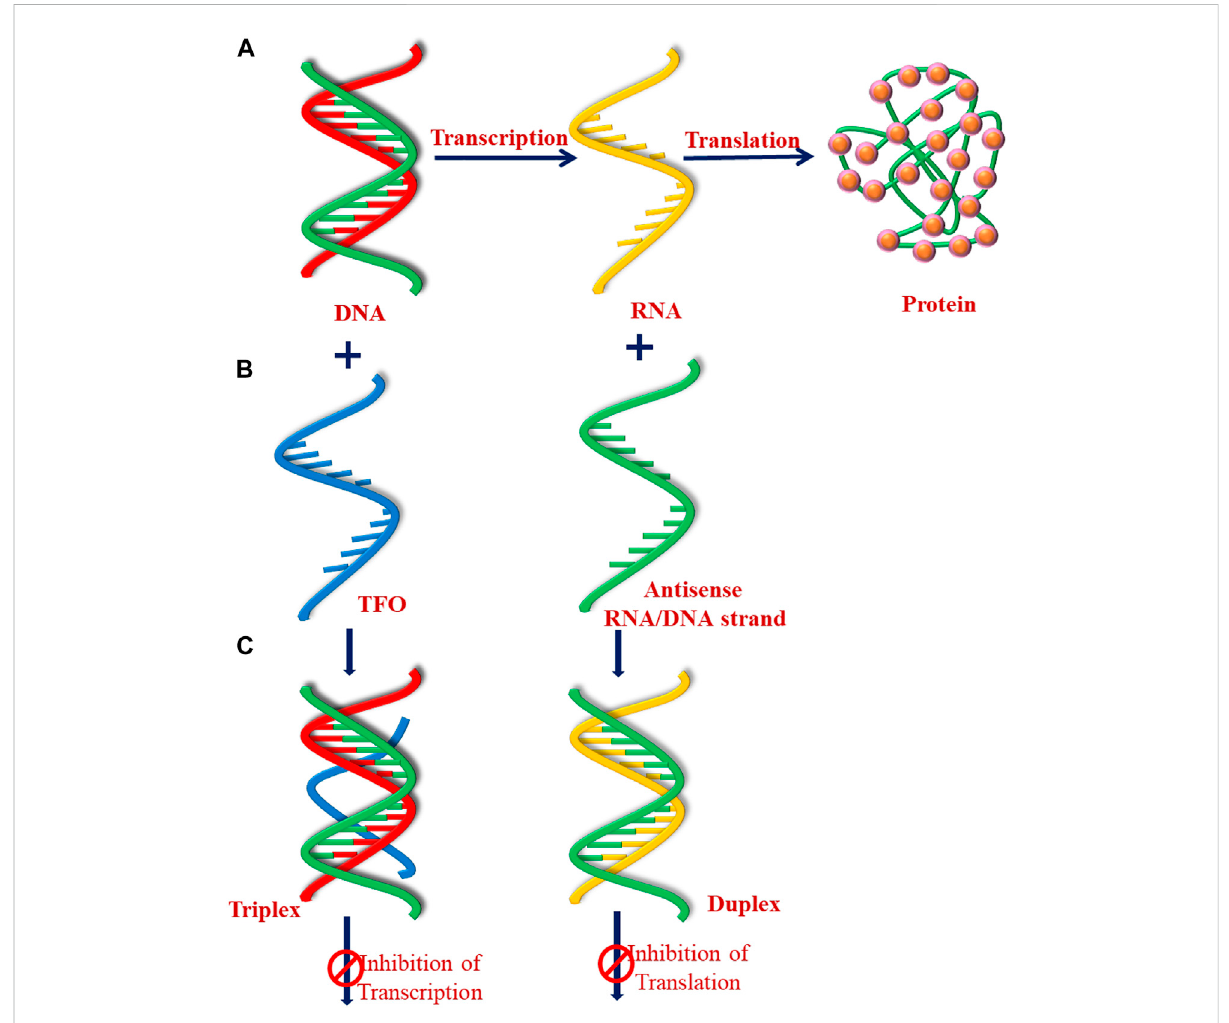
FIGURE 9 Schematic represent of (A) central dogma of molecular biology, (B) antigene, and (C) antisense